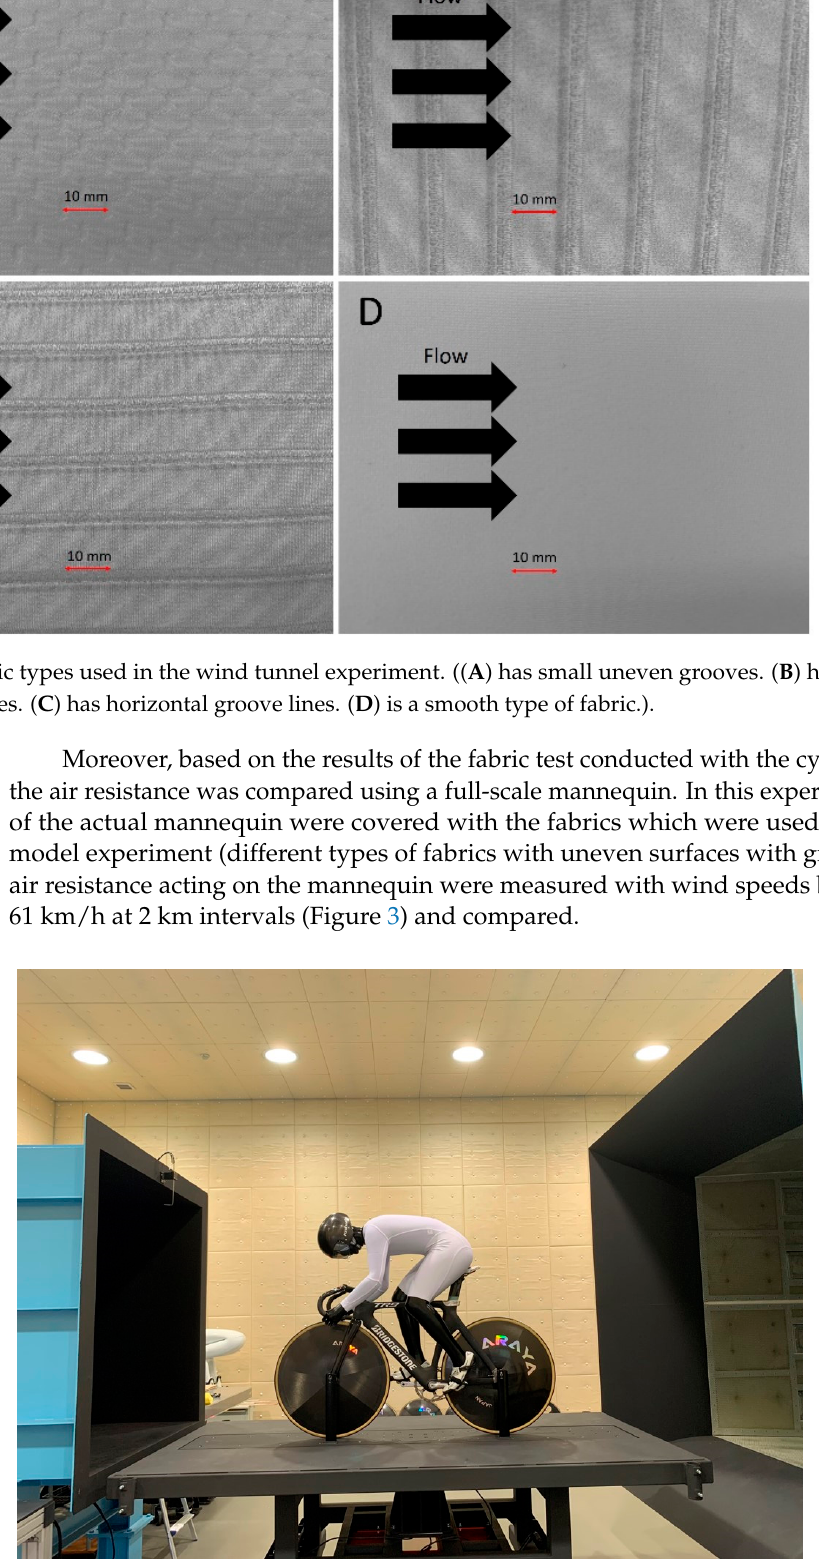
Figure 3. Full-scale mannequin used in the wind tunnel experiment.